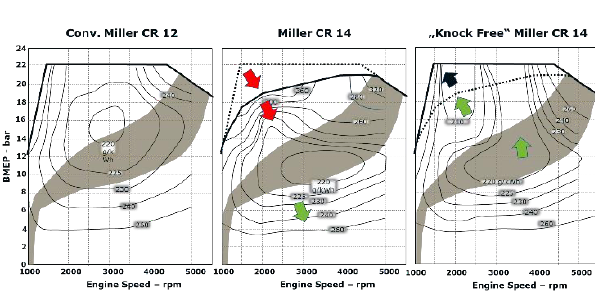
Fig. 19. Impact of a knock reduced combustion process in the engine map, no EGR With an "ICE only" powertrain, the reduced full load torque would require a shorter drive ratio for